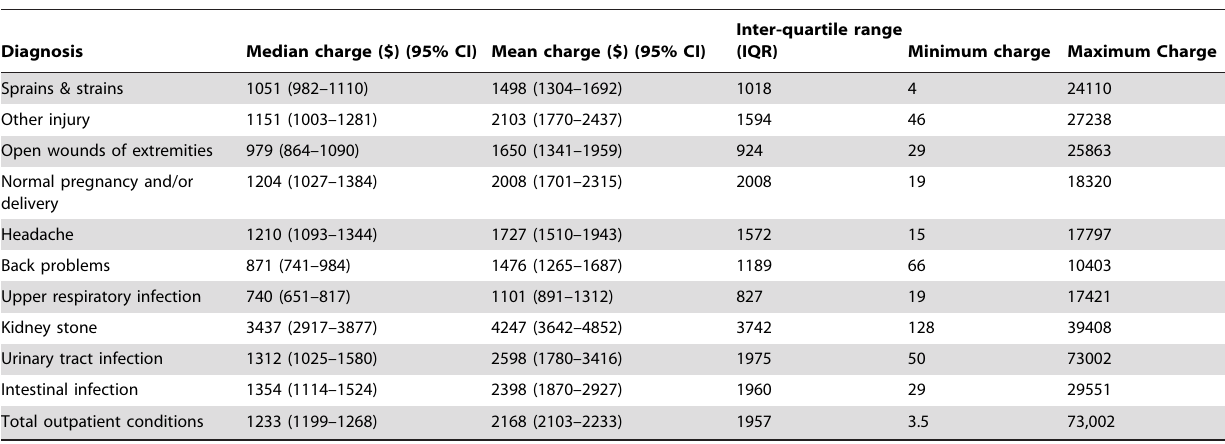
Table 3. Emergency department charges for the ten most common outpatient conditions.